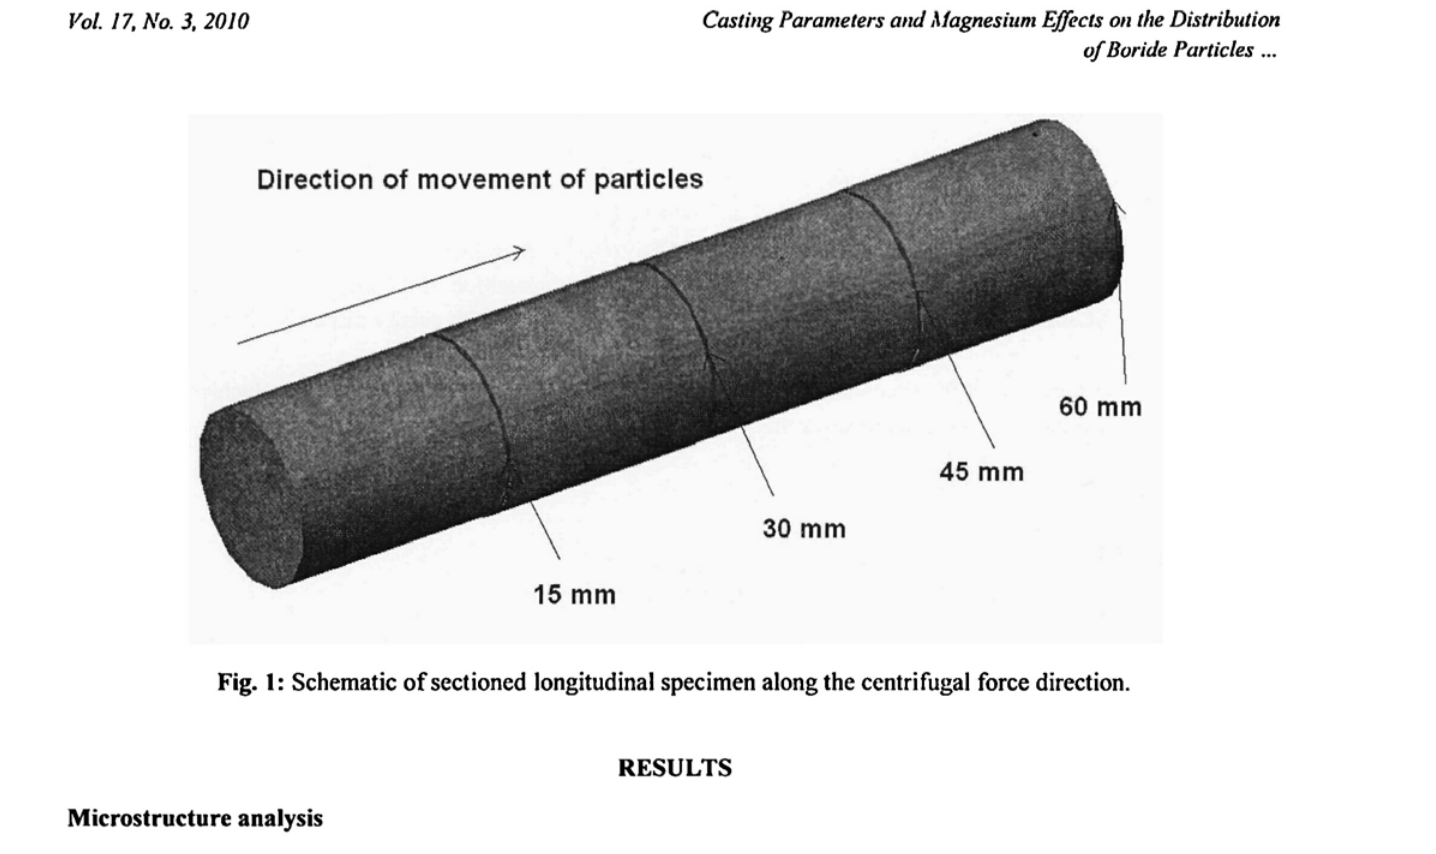
Fig. 1: Schematic of sectioned longitudinal specimen along the centrifugal force direction.